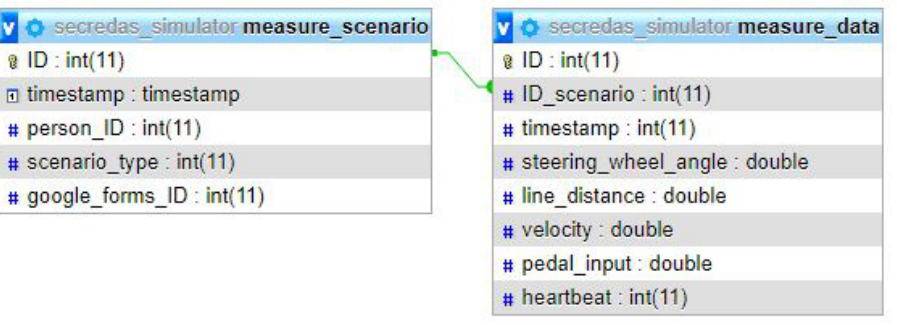
Figure 8. The data model of the remote